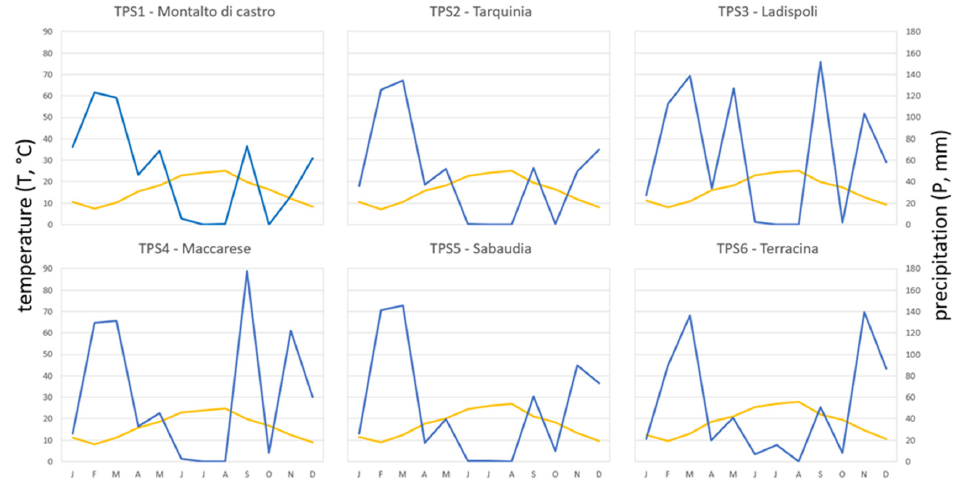
Figure 6. Plots obtained using data of temperature (T, °C, in orange) and precipitation (P, mm, in blue) from the six coastal meteorological thermo-pluviometric stations (TPS) indicated in Figure 1.